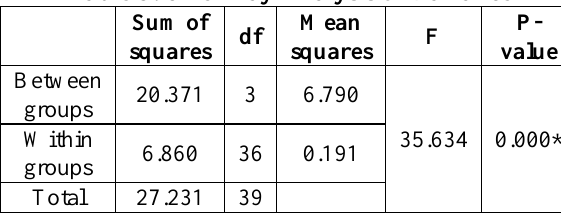
Table 3: One-Way Analysis of Variance Sum of